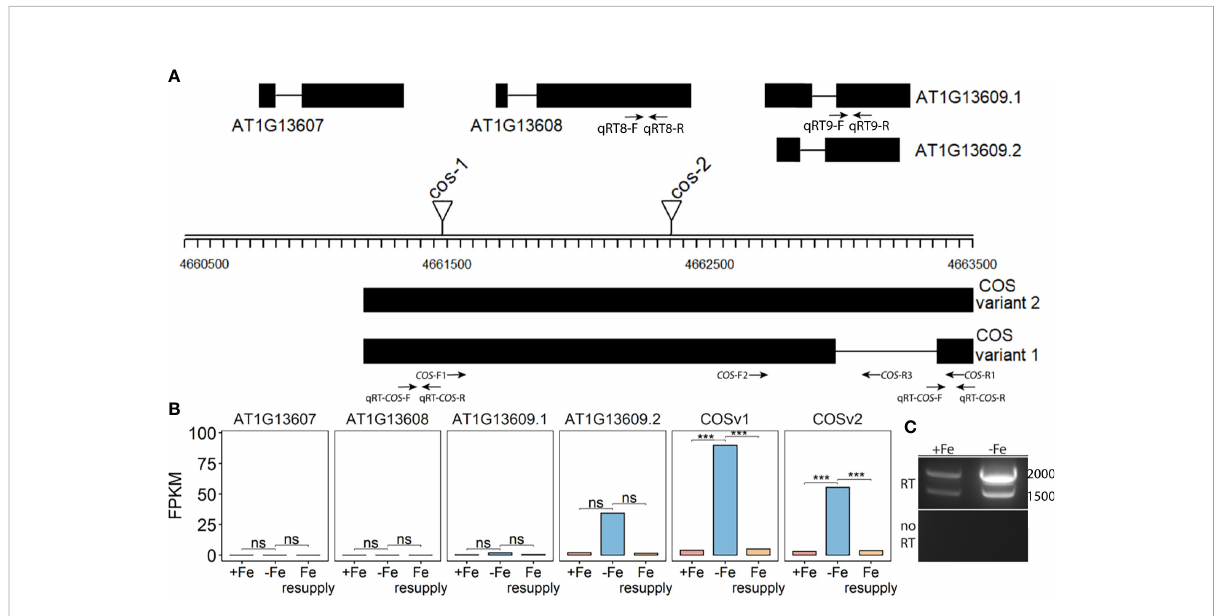
FIGURE 1 CAN OF SPINACH ( COS ), a novel long non-coding RNA (lncRNA). (A) Schematic representation of the locus. On the top strand, three genes (AT1G13607, AT1G13608 and AT1G13609) are annotated. The lncRNA COS is on the bottom strand. Thick boxes represent exons, lines represent introns. Positions of T-DNA insertion mutants used in this study are represented as triangles. Primers used in the study are represented as arrows at the bottom. (B) Bar plot representing the expression levels of various predicted transcripts under Fe suf fi cient, Fe de fi cient and Fe resupply conditions. Values from RNAseq are represented as fragments per kilobase of exon per million mapped fragments (FPKM). (C) RT-PCR using primers COS-F1 and COS-R1, using total RNA from shoots. Absence of genomic DNA contamination was con fi rmed by the lack of ampli fi cation of the no-RT control. cDNA was synthesized using oligodT (20) . *** represents p-value ≤ 0.0001. ns, not signi fi